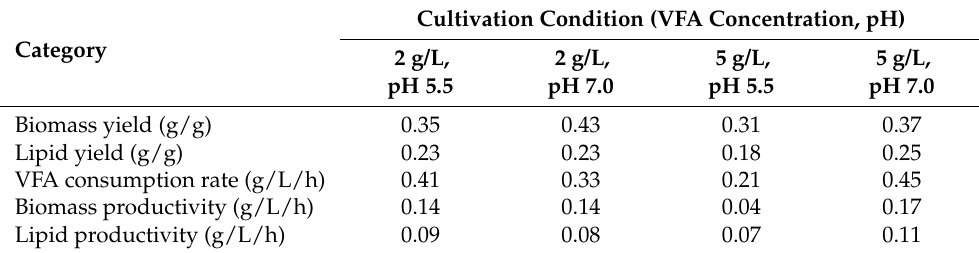
Table 2. Comparison of different automatic fed-batch cultivation